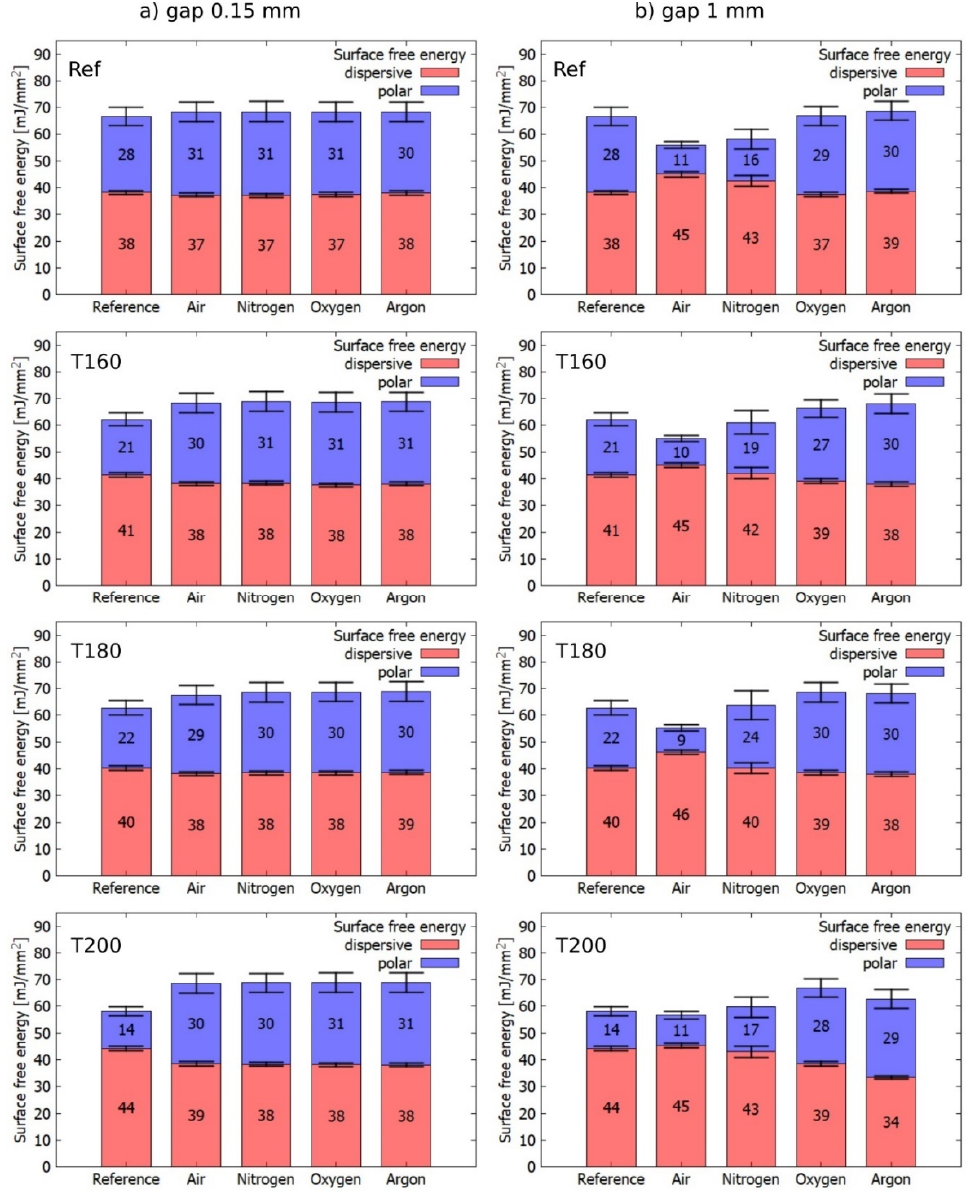
Figure 5. Comparison of surface free energies for different gases during plasma activation of wood. ( a ) in case of 0.15 mm gap and ( b ) in case of 1 mm gap from the electrode.